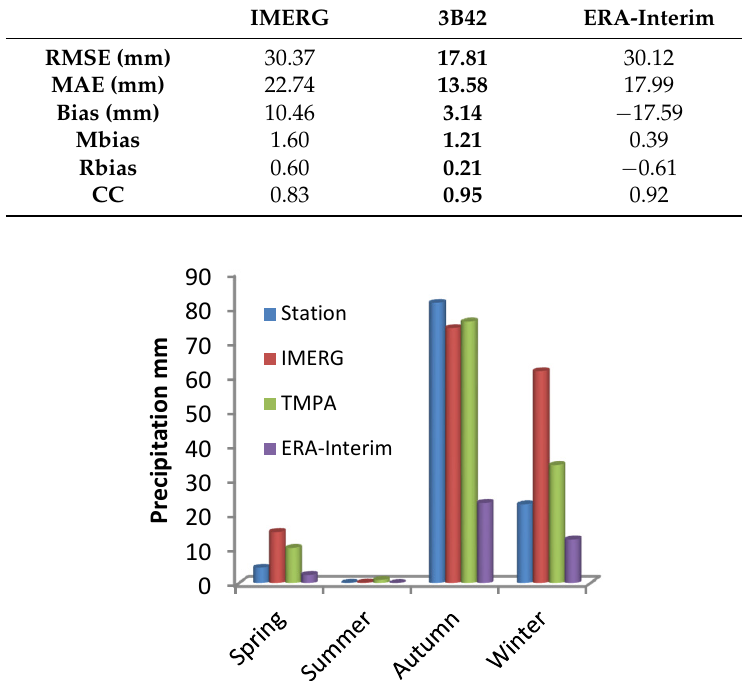
0.88 Figure 14. Kermanshah seasonal precipitation. IMERG and ERA-Interim displayed underestimation and 3B42 overestimation over Tehran region. Among these products, IMERG has better results in comparison with the other data sets while ERA-Interim yields a smaller magnitude of error (Figure 15 and Table 15).